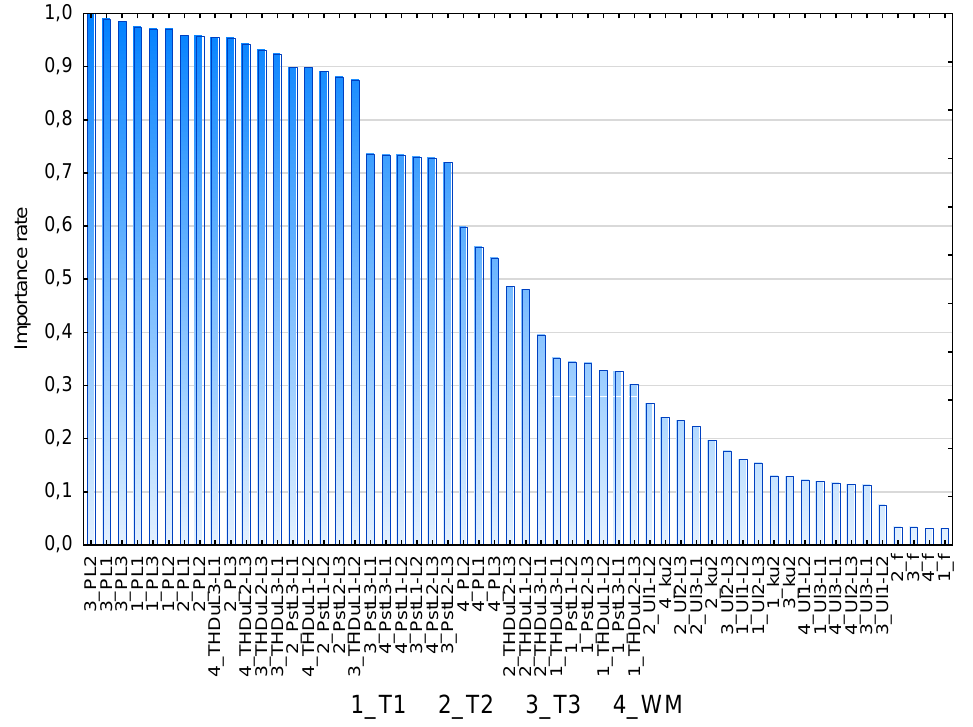
Figure 10. Importance rate of the factors to the output of the cluster analysis results for the final number of clusters equal to 6.